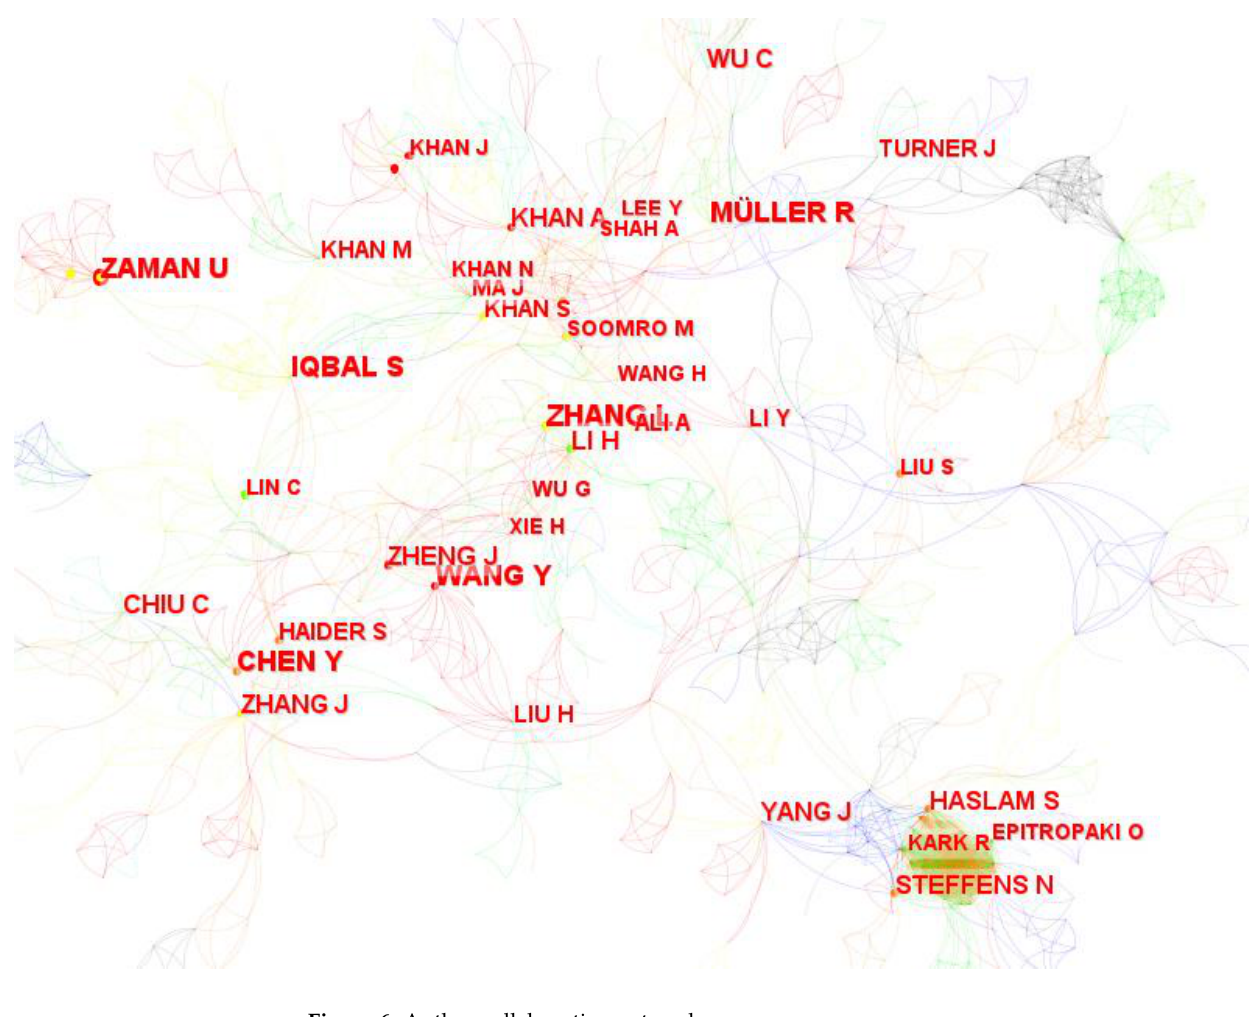
Figure 6. Author collaboration network . Table 3. Top 10 authors based on the number of publications .